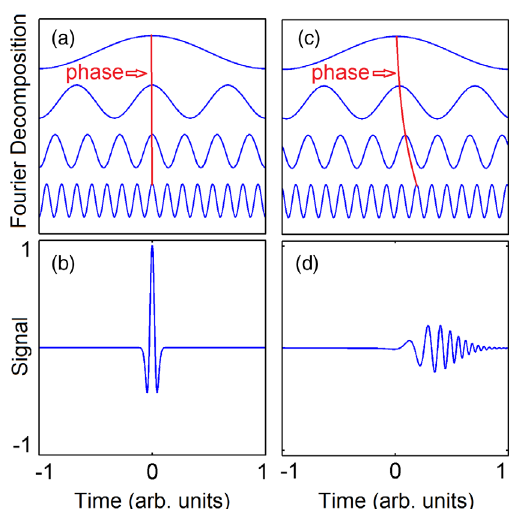
FIG. 1. Schematic illustration of the Fourier decompositions (a) and (c) of the quasi-half-cycle (b) and frequency-chirped (d) pulses, respectively. The quasi-half-cycle pulse is formed by the superposition of in-phase sinusoidal components, whereas the frequency-chirped pulse is composed of the sinusoidals with a nonlinear phase shift in between them. The amplitudes of the Fourier components are not to scale.